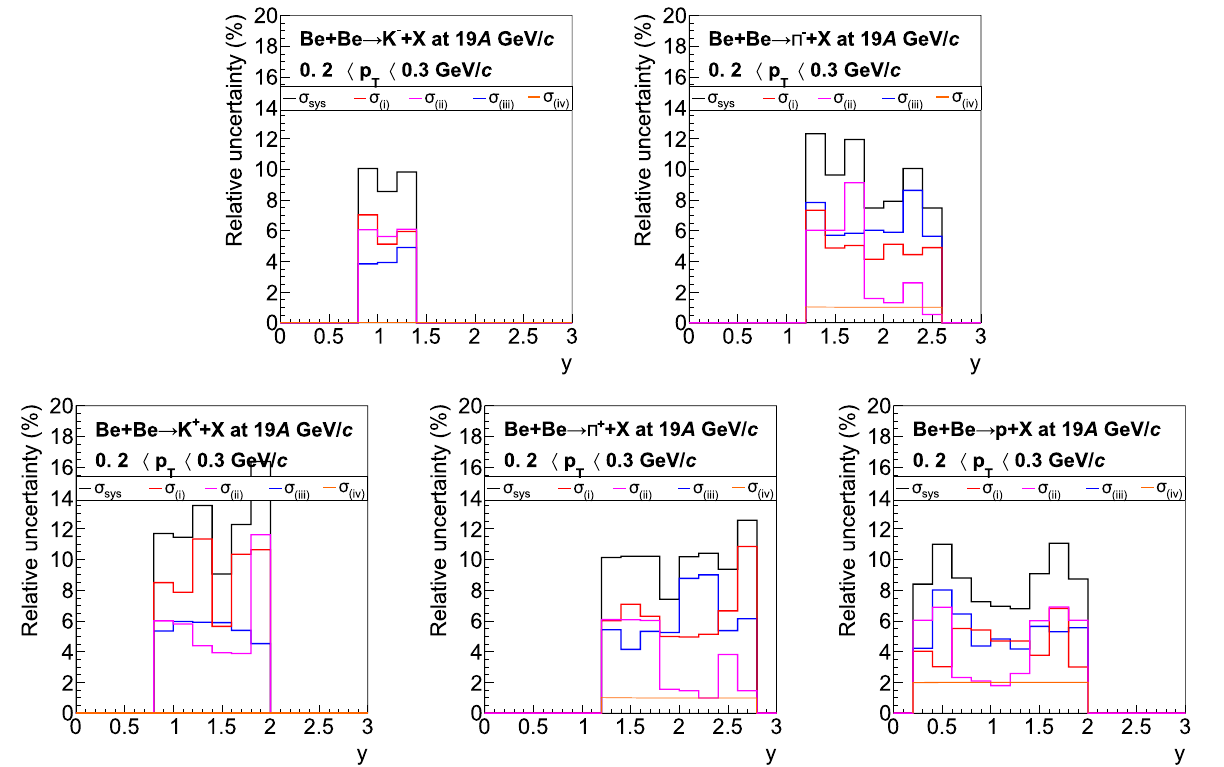
Fig. 16 Contributions to the systematic uncertainty of particle spectra obtained from the d E / d x method at 19 A GeV / c as a function of rapid- ity for the transverse momentum interval between 0.2–0.3 GeV / c . σ (i) (red lines) refers to event selection σ (ii) (magenta lines) to the track selection procedure, σ (iii) (blue lines) to the identification technique